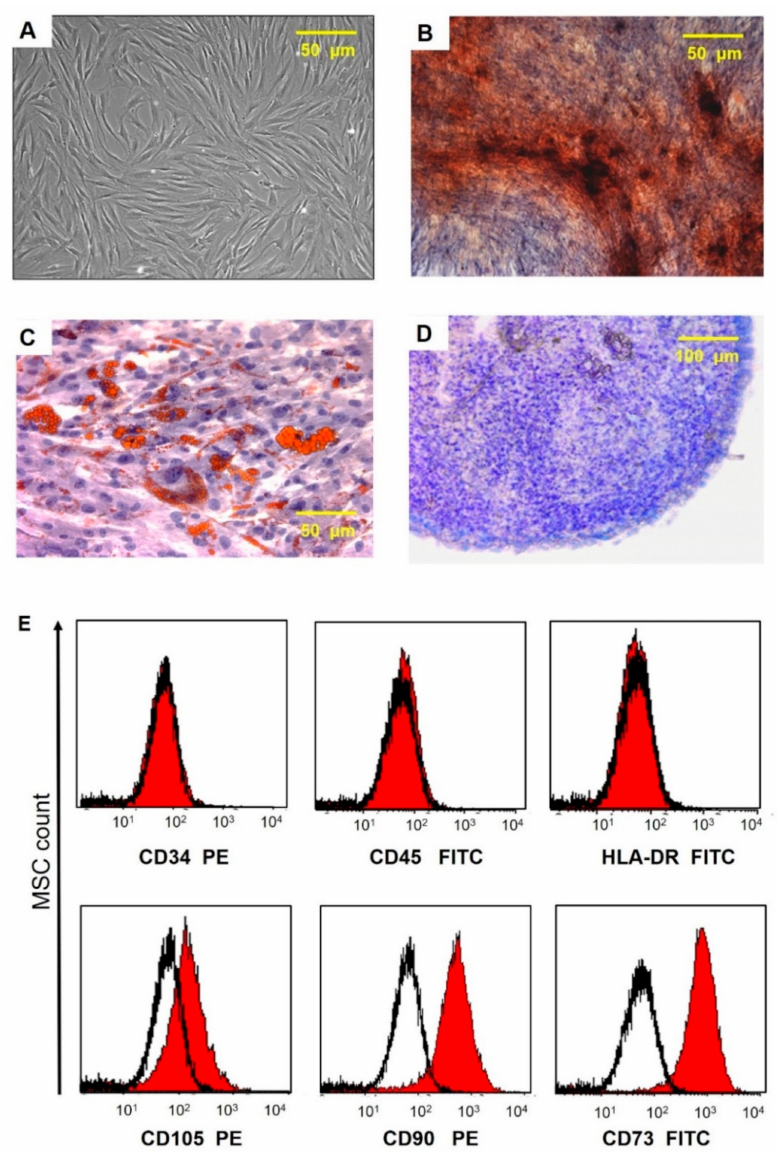
Figure 2. Morphological characteristics, immunocytophenotypic profile, and differentiation potential of umbilical cord MSCs. ( A ) Phase contrast image of adherent MSC with fibroblast-like morphology is shown at passage 3. ( B ) Calcium deposits in MSC (staining with alizarin red). ( C ) Lipid vacuole formation in MSCs (staining with oil red and hematoxylin); ( D ) Mucopolysaccharide extracellular matrix formation (cryosections of micromasses stained with toluidine blue). ( E ) Flow fluorometry histograms demonstrating the expression of surface antigens in MSC labeled with FITC- and PE- conjugated antibodies to surface markers CD90, CD73, CD105, CD34, CD45, and HLA-DR (red area) are plotted against isotype control (black